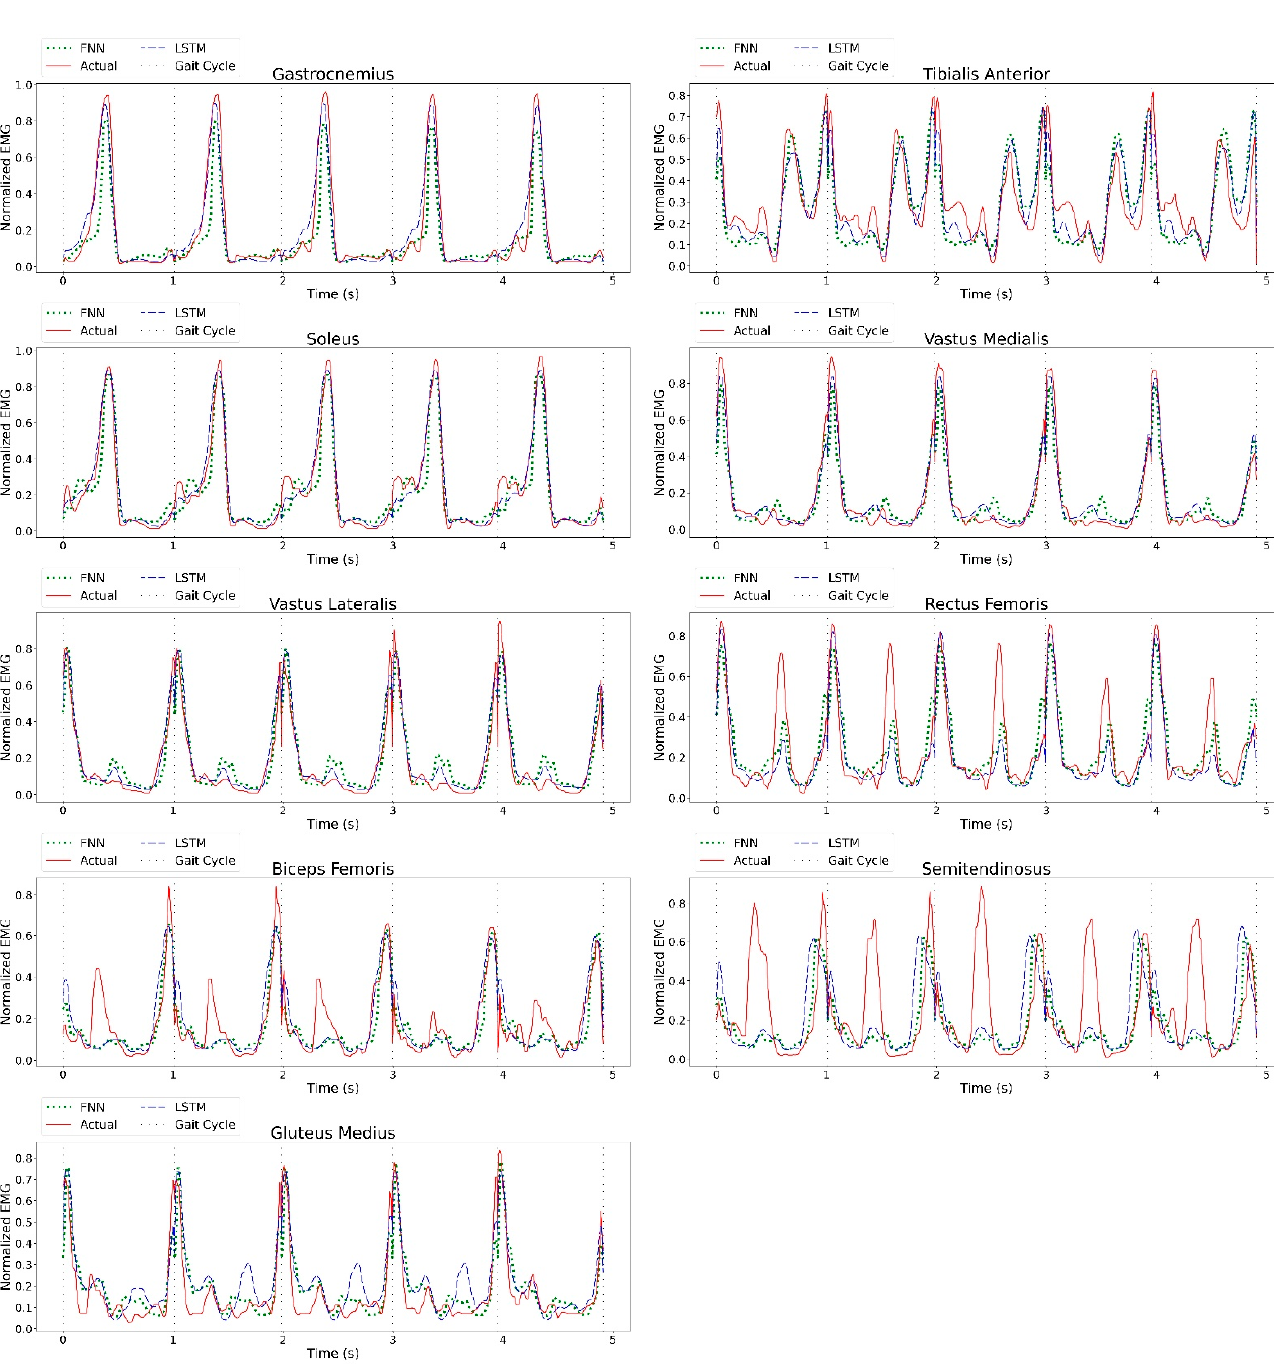
Figure A4. A plot of actual vs. predicted muscle activities of the unseen data (Sample A).